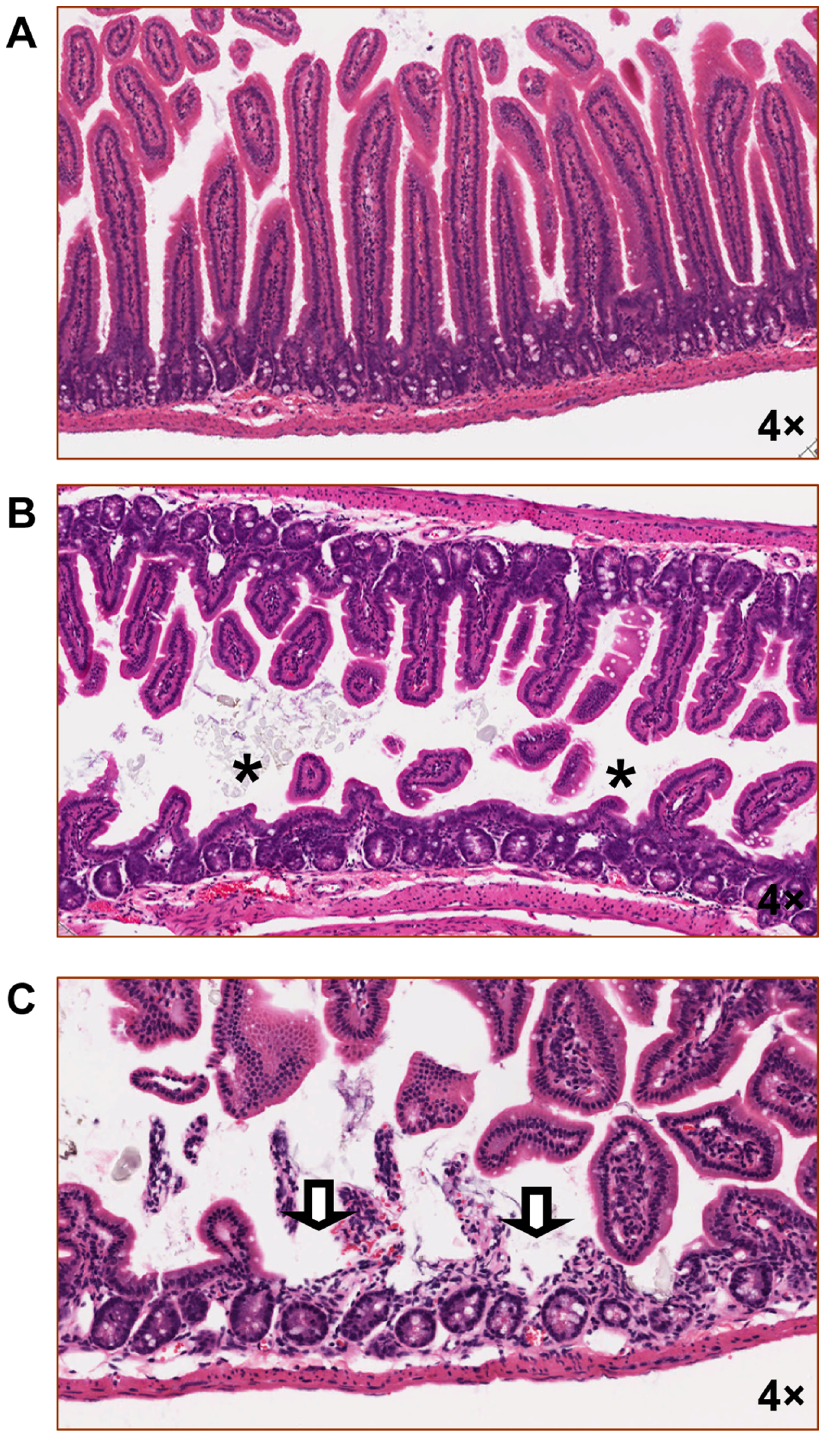
Figure 6. Gastrointestinal anthrax is marked by histological damage prior to hematological dissemination . Tissues were collected from mice 2 h (A) or 40 h (B and C) following intragastric challenge with BaS (1.3 6 10 9 ). At neither of these time points were these BaS-challenged mice bacteremic. Representative images generated from H&E-stained sections from mice in each of these cohorts are shown. Asterisks indicate regions of villous blunting, whereas block arrows indicate focal regions of ulceration.